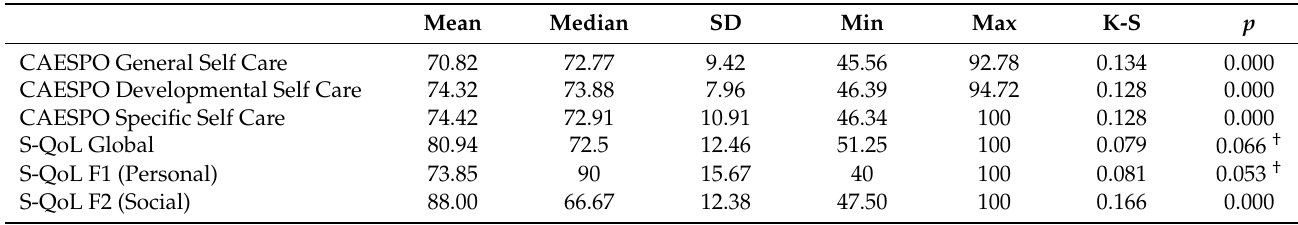
Table 3. Descriptive statistics of Questionnaires.